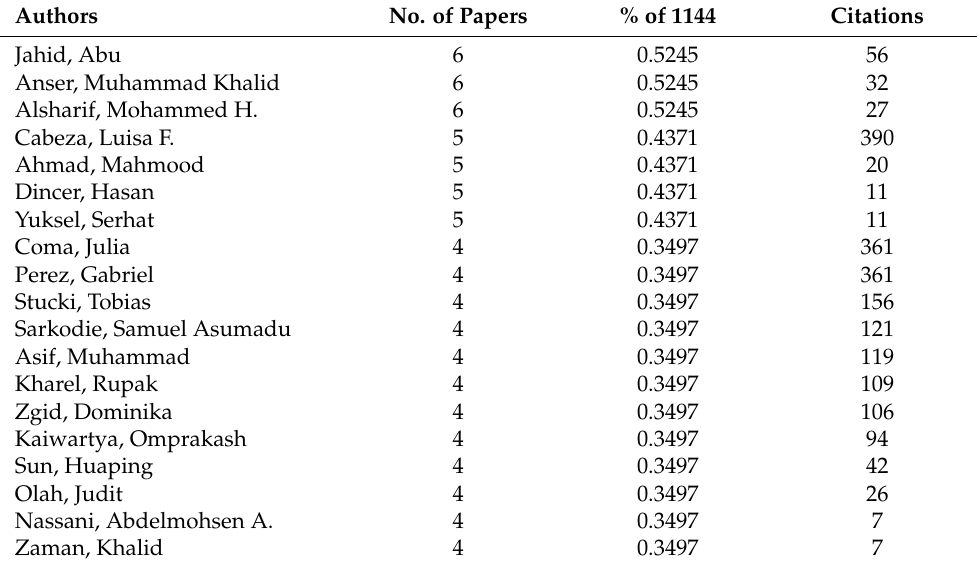
Table 1. The leading authors of documents on green and renewable energy and innovation.